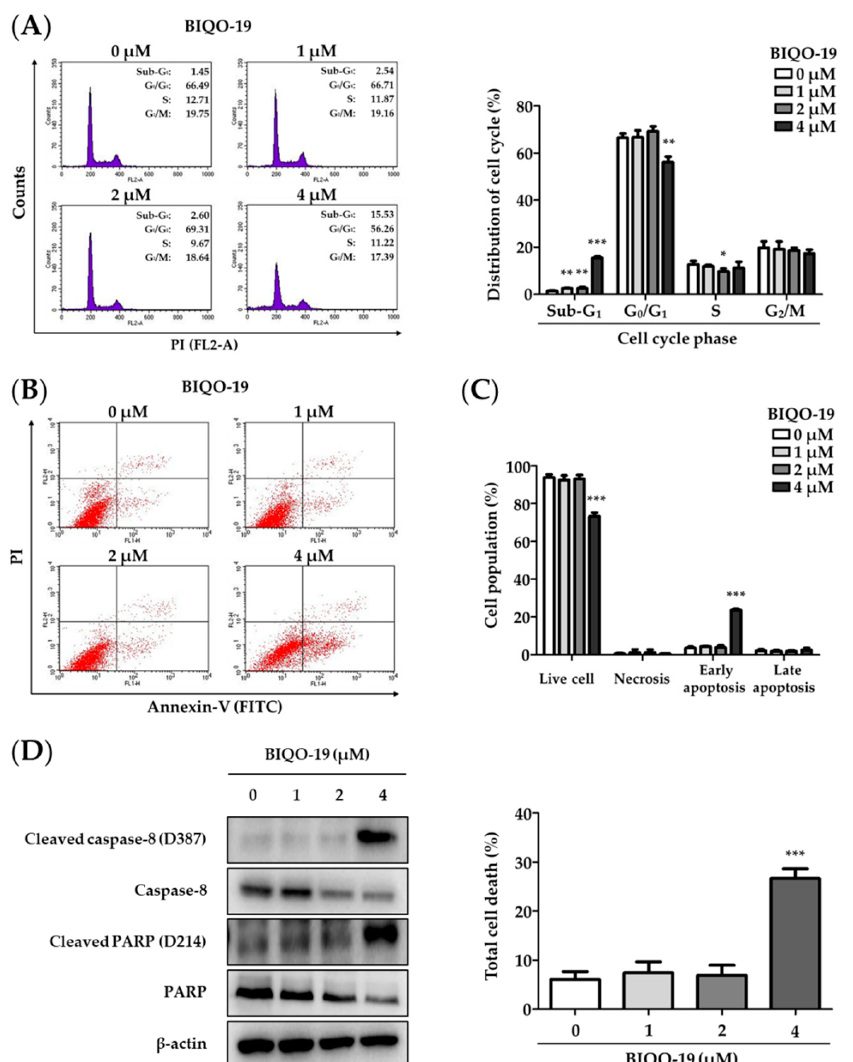
Figure 5. Effects of BIQO-19 on the induction of apoptosis in H1975 cells. ( A ) Cells were treated with various concentrations of BIQO-19 for 72 h, collected, fixed, and stained with PI. The cell cycle distribution was analyzed by flow cytometry. Histograms are presented as a representative of three independent experiments (left panel) and data are presented as the means ± SD ( n = 3). * p < 0.05, ** p < 0.01, and *** p < 0.001 indicate a statistically significant difference compared with the vehicle-treated control group (right panel). ( B , C ) Cells were treated with BIQO-19 for 72 h and stained with Annexin V-fluorescein isothiocyanate (FITC) and PI. After staining, cell populations with Annexin V/FITC (+) and/or PI (+) were analyzed by flow cytometry ( B ). The percentage of each cell population (live, necrosis, early apoptosis, late apoptosis) ( C , upper panel) and the percentage of total cell death (early apoptosis + late apoptosis + necrosis) were quantified and displayed as % of control ( C , bottom panel). Data were obtained from three independent experiments and are presented as the means ± SD. *** p < 0.001 indicates a statistically significant difference compared with the vehicle-treated control group. ( D ) Cells were treated with various concentrations of BIQO-19 for 72 h and the expression levels of cleaved caspase-8, caspase-8, cleaved PARP, and PARP were analyzed by Western blotting analysis. β -Actin was used as an internal